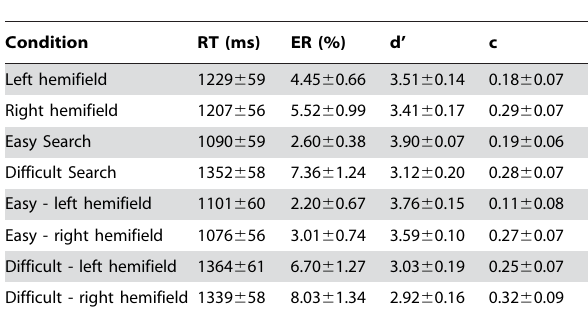
Table 1. Summary of behavioral